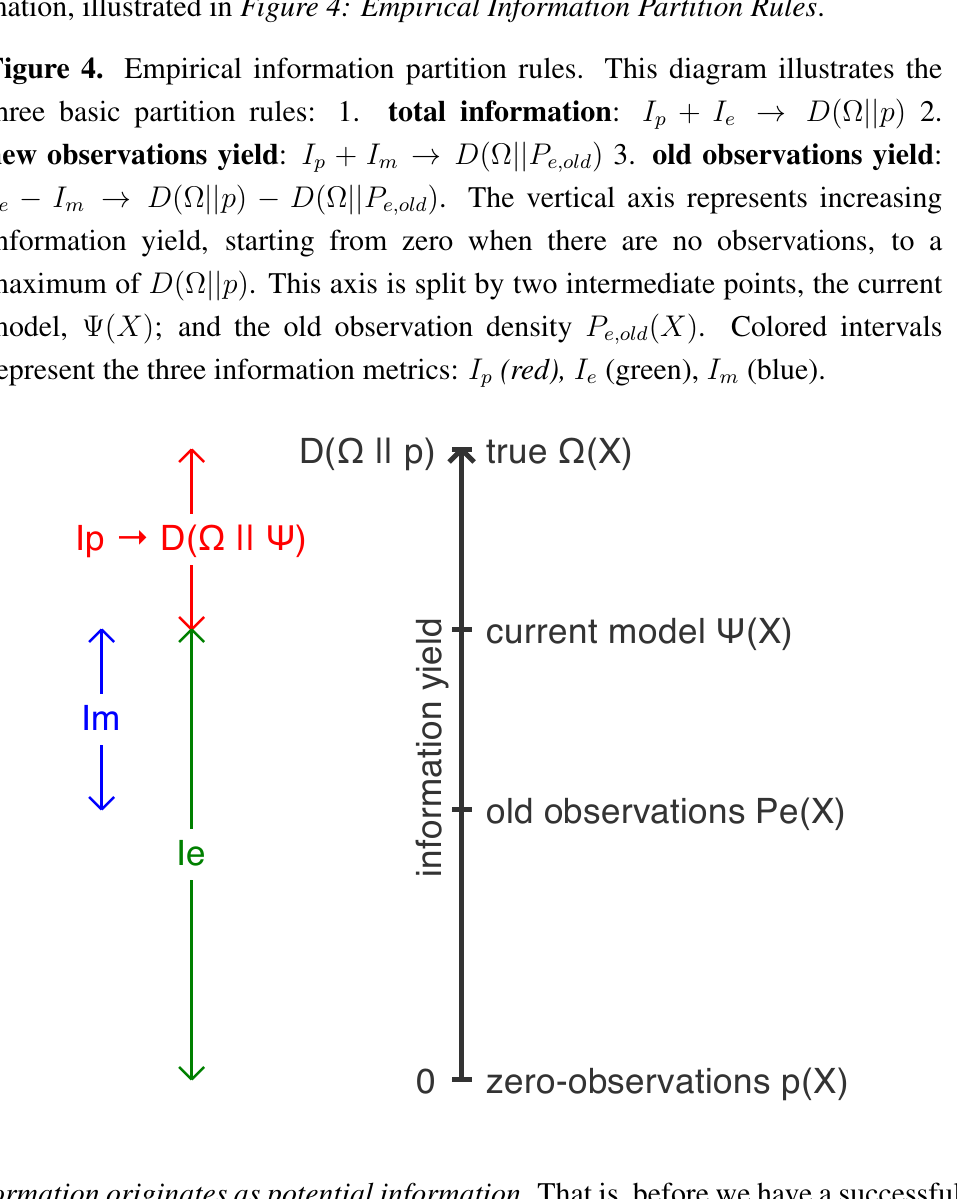
three basic partition rules: 1. total information : I